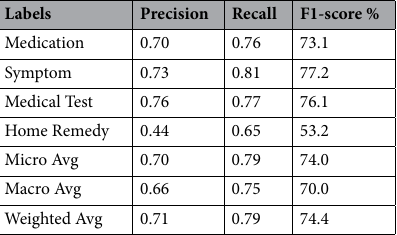
Table 2. Precision, Recall and F1-scores for the MEP Model.